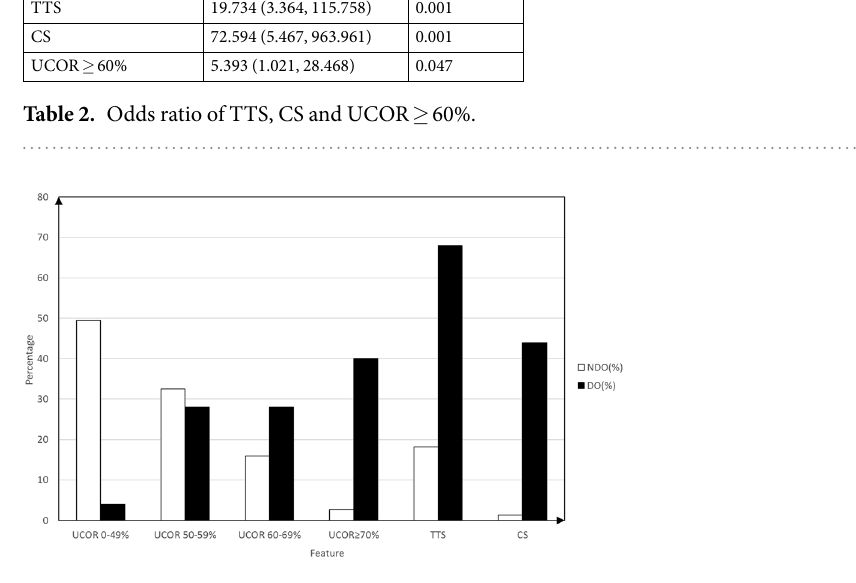
Figure 1. Distribution of UCOR, tram track sign and C-sign values. UCOR indicates unilateral spinal canal occupational rate. TTS indicates the tram track sign. CS indicates the C-sign. NDO indicates TOLF without DO. DO indicates TOLF with DO.